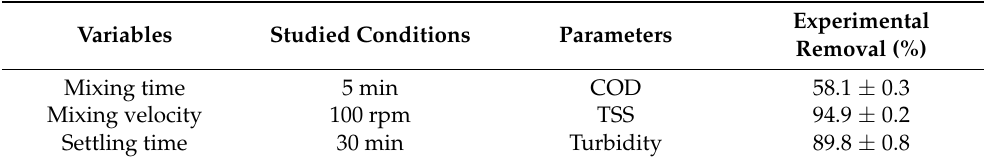
Figure 2. Theoretical TSS, turbidity and COD removal values for different mixing times and mixing speeds, at a fixed settling time of 30 min (graphics obtained from the Design Expert 11 software). Subsequently, coagulation tests were carried out with the optimum conditions ob- tained from the software. Table 7 illustrates the results of these tests in terms of TSS, tur- bidity and COD removal values. Table 7. Experimental removal using optimal conditions extracted from Design Expert 11. The errors represent standard deviation (n = 3).